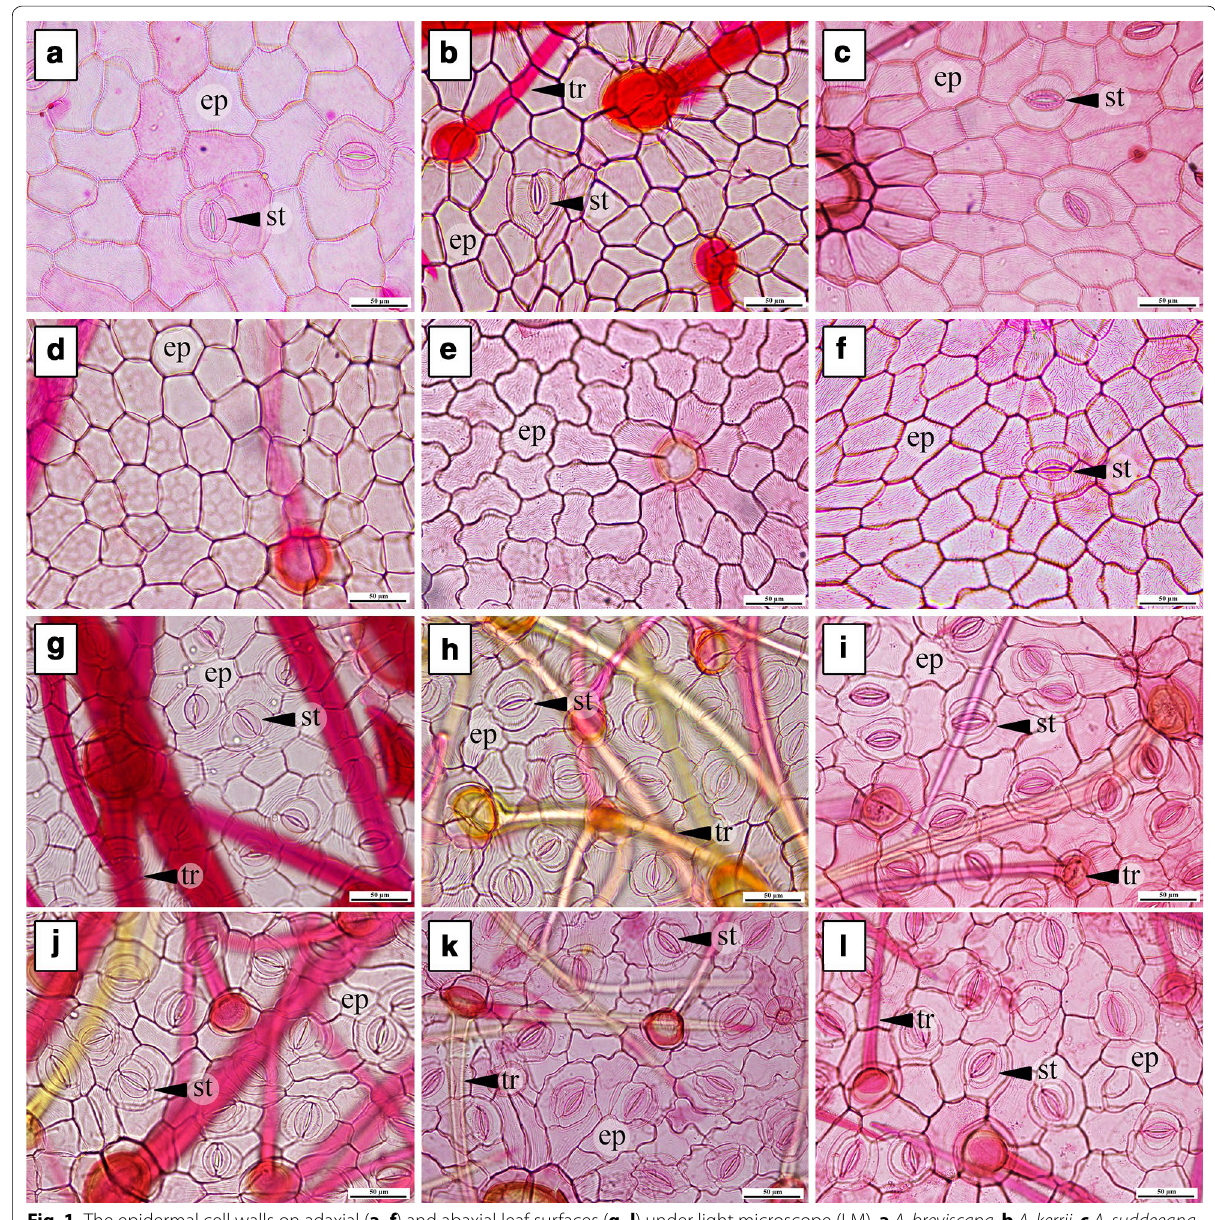
Fig. 1 The epidermal cell walls on adaxial ( a – f ) and abaxial leaf surfaces ( g – l ) under light microscope (LM). a A. breviscapa , b A. kerrii , c A. suddeeana , d A. variabilis and f Argyreia 2, straight to slightly curved walls. e Argyreia 1, sinuate walls. g A. breviscapa and j A. variabilis , straight to slightly